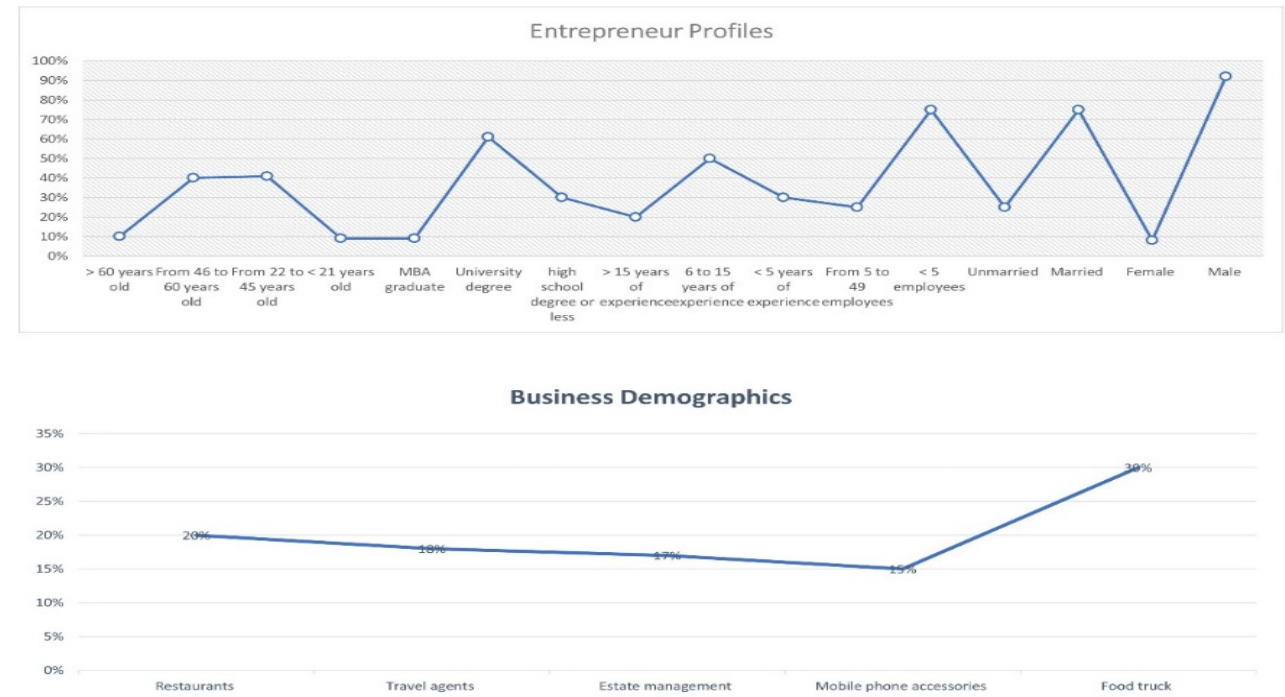
Figure 2. Entrepreneur profiles and business demographics. Source: Developed by authors.